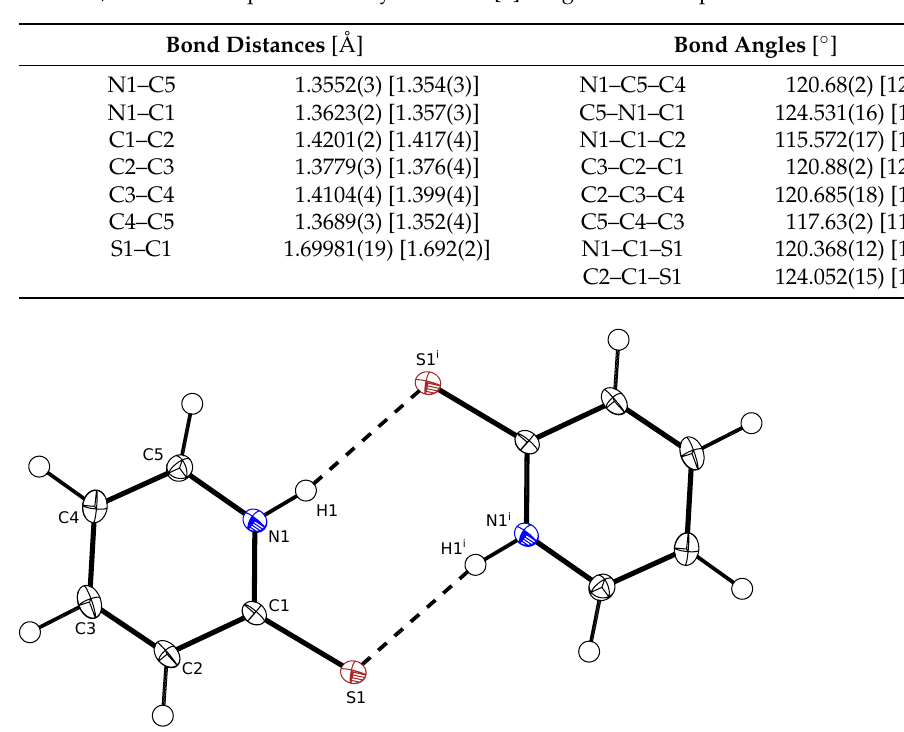
Table 2. Intramolecular geometry in (I) after refinement with the independent atom model. In square brackets, the room-temperature X-ray results of [4] are given for comparison.